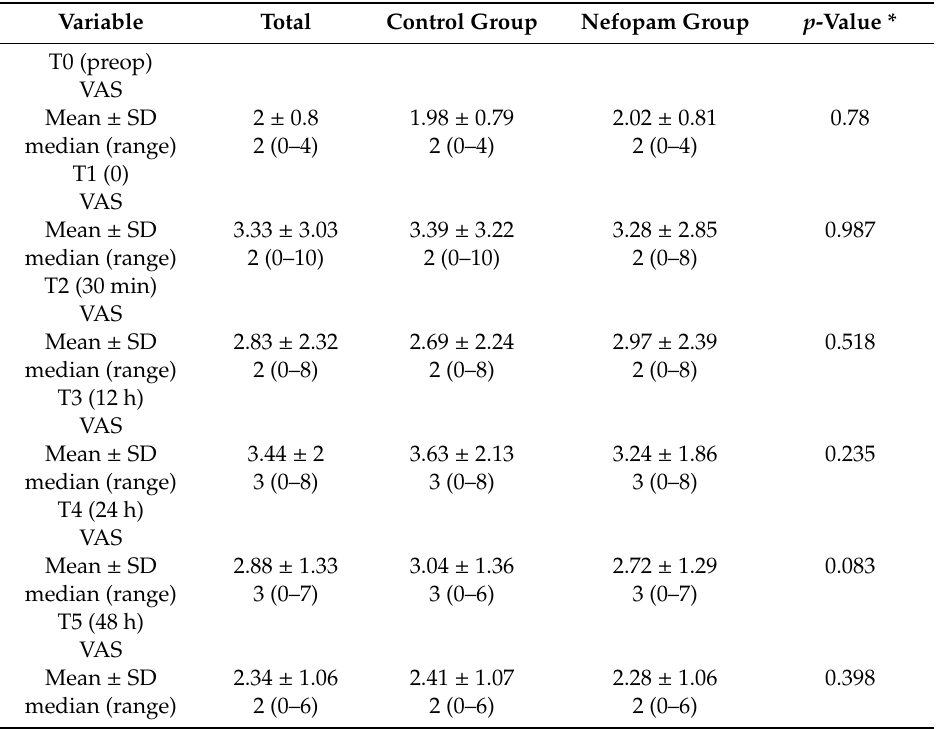
Table 2. Association between nefopam and VAS at each time point.